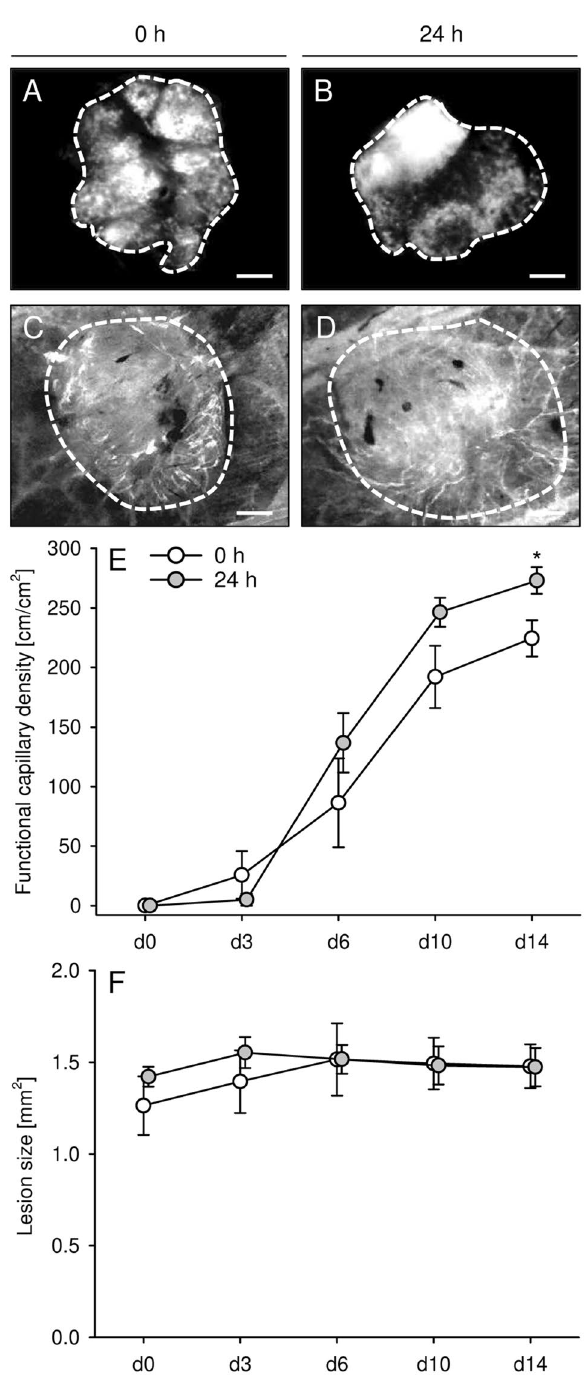
Figure 7. ( A – D ) Intravital fluorescent microscopic images of endometriotic lesions (broken lines = borders) on day 0 ( A , B ) and day 14 ( C , D ) after transplantation of freshly isolated (0 h; A , C ) and 24-h-precultivated ( B , D ) endometrial fragments from C57BL/6-TgN(ACTB-EGFP)1Osb/J donor mice into the dorsal skinfold chamber of C57BL/6J recipient mice. Microscopy was performed in blue light epi-illumination without ( A , B ) or with 5% FITC-labeled dextran for contrast enhancement by staining of plasma ( C , D ). Scale bars: 270 µm. ( E , F ) Functional capillary density ( E , cm/cm 2 ) and size ( F , mm 2 ) of endometriotic lesions directly after transplantation (d0) as well as on days 3, 6, 10 and 14 day after transplantation of freshly isolated (0 h; white bars; n = 5) and 24-h-precultivated (grey bars; n = 7) endometrial fragments from C57BL/6-TgN(ACTB- EGFP)1Osb/J donor mice into dorsal skinfold chambers of C57BL/6J recipient mice. Mean ± SEM. *P < 0.05 vs. 0